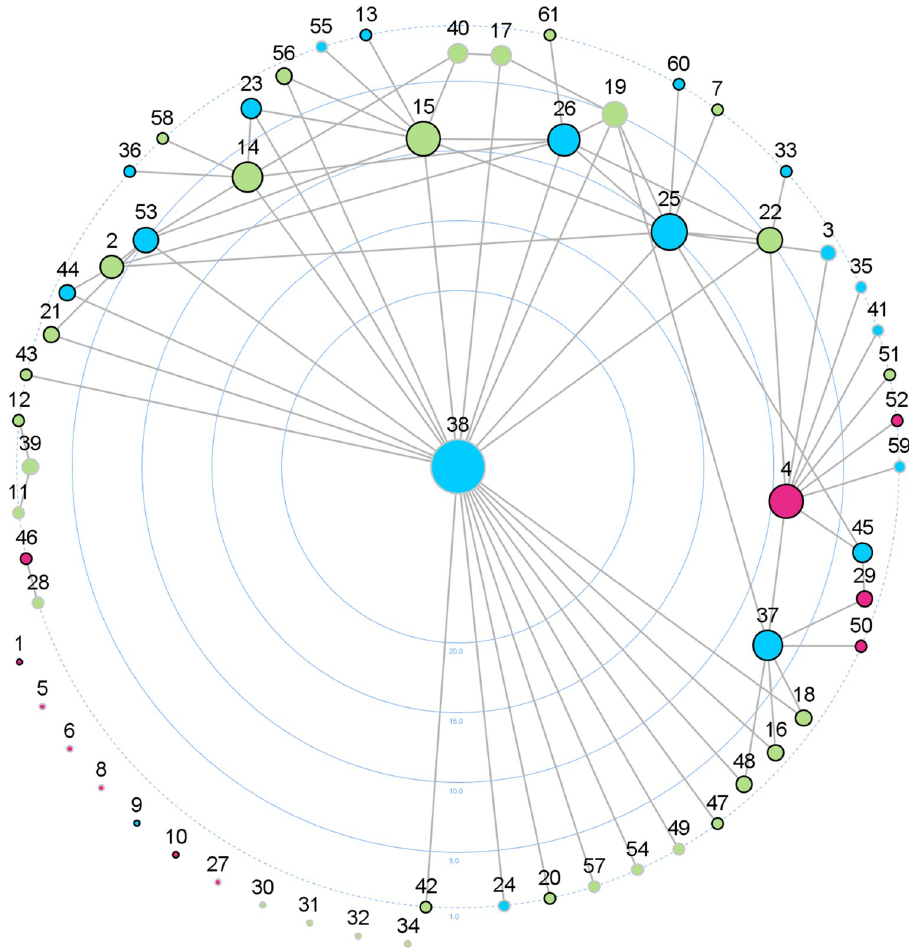
Fig 3. Degree centrality visualization (number of ties) of the PAP network of cooperation ( n = 61).